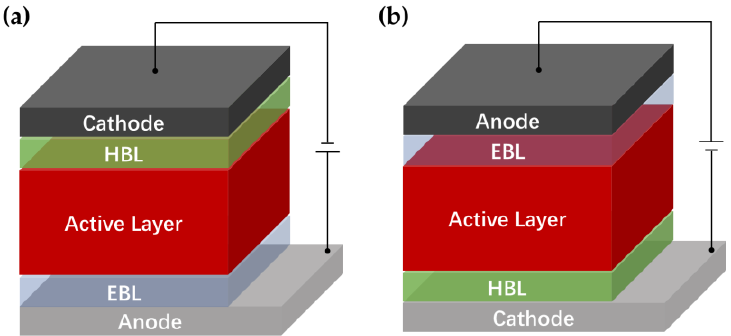
Figure 3. ( a ) Conventional and ( b ) inverted structure of organic